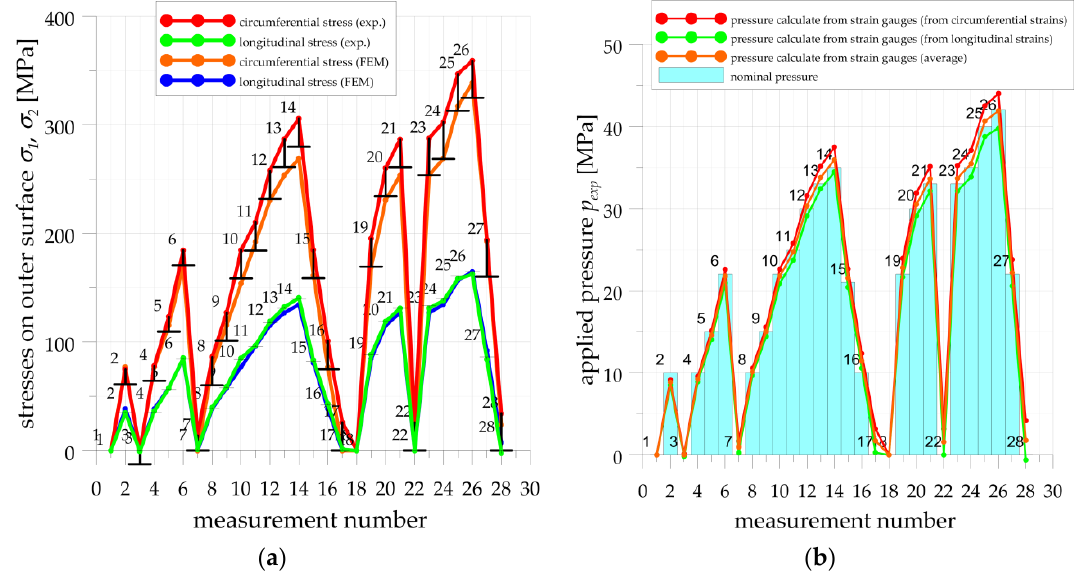
Figure A5. Results obtained from rosette T2.5: ( a ) experimental and numerical principal stresses on outer surface of cylindrical pipe; ( b ) calculated internal pressure from strain measurements. Table A4. Internal pressures calculated from rosette T2.5 for measurements with unloaded